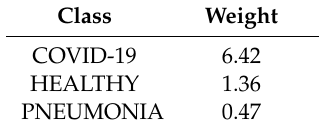
Table 1. Matrix of weights to penalize cost function.